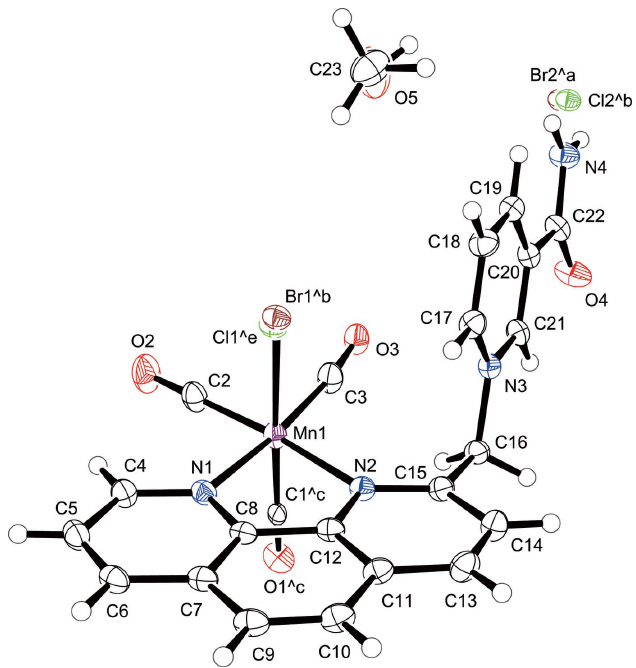
Figure 1 The structures of the molecular components in the title salt ( C isomer; i.e. only the major components of the disorder between X 1 and C1 O1 are shown), with atom labels and displacement ellipsoids for non-H atoms drawn at the 50% probability